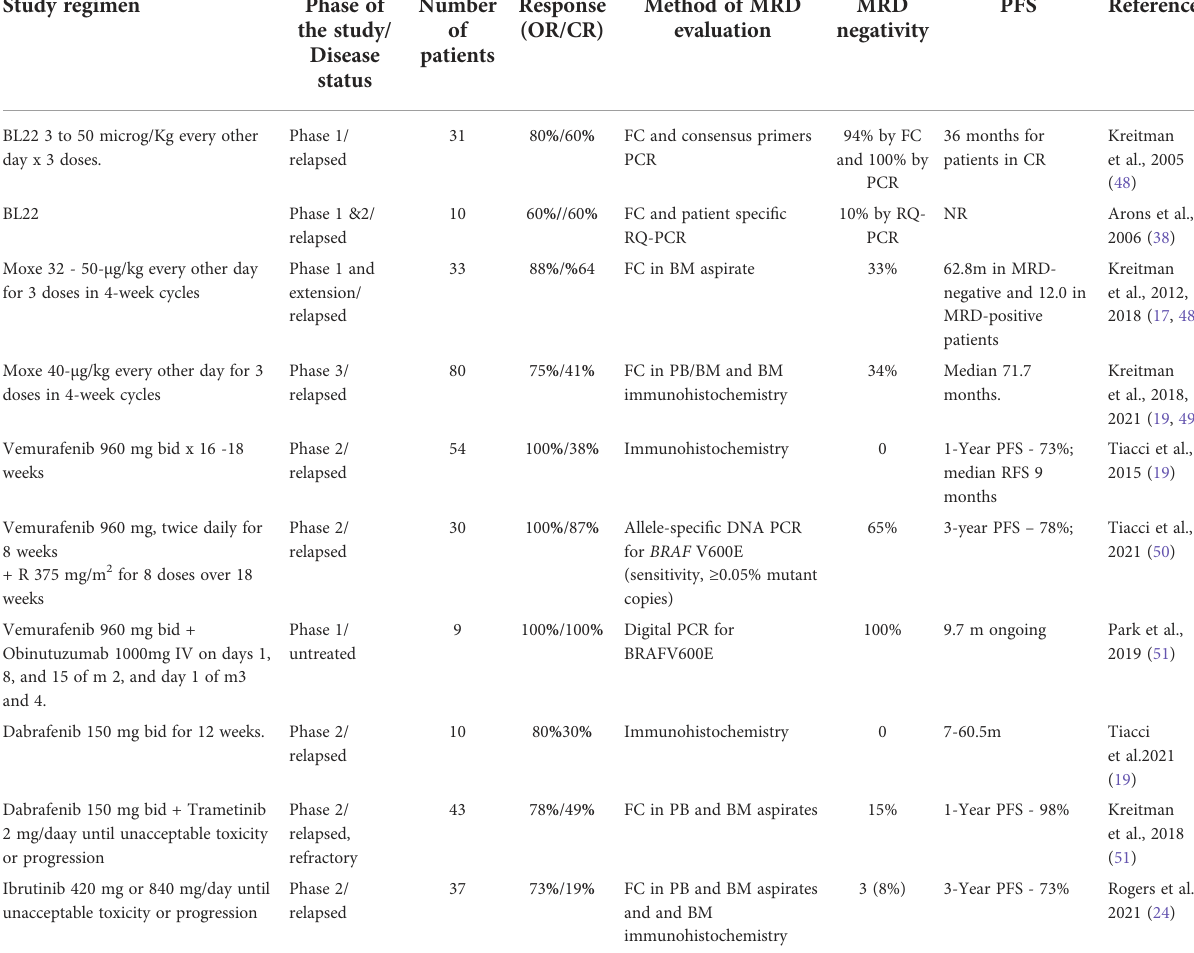
TABLE 2 Clinical studies with MRD evaluation in patients with HCL treated with novel agents. Study